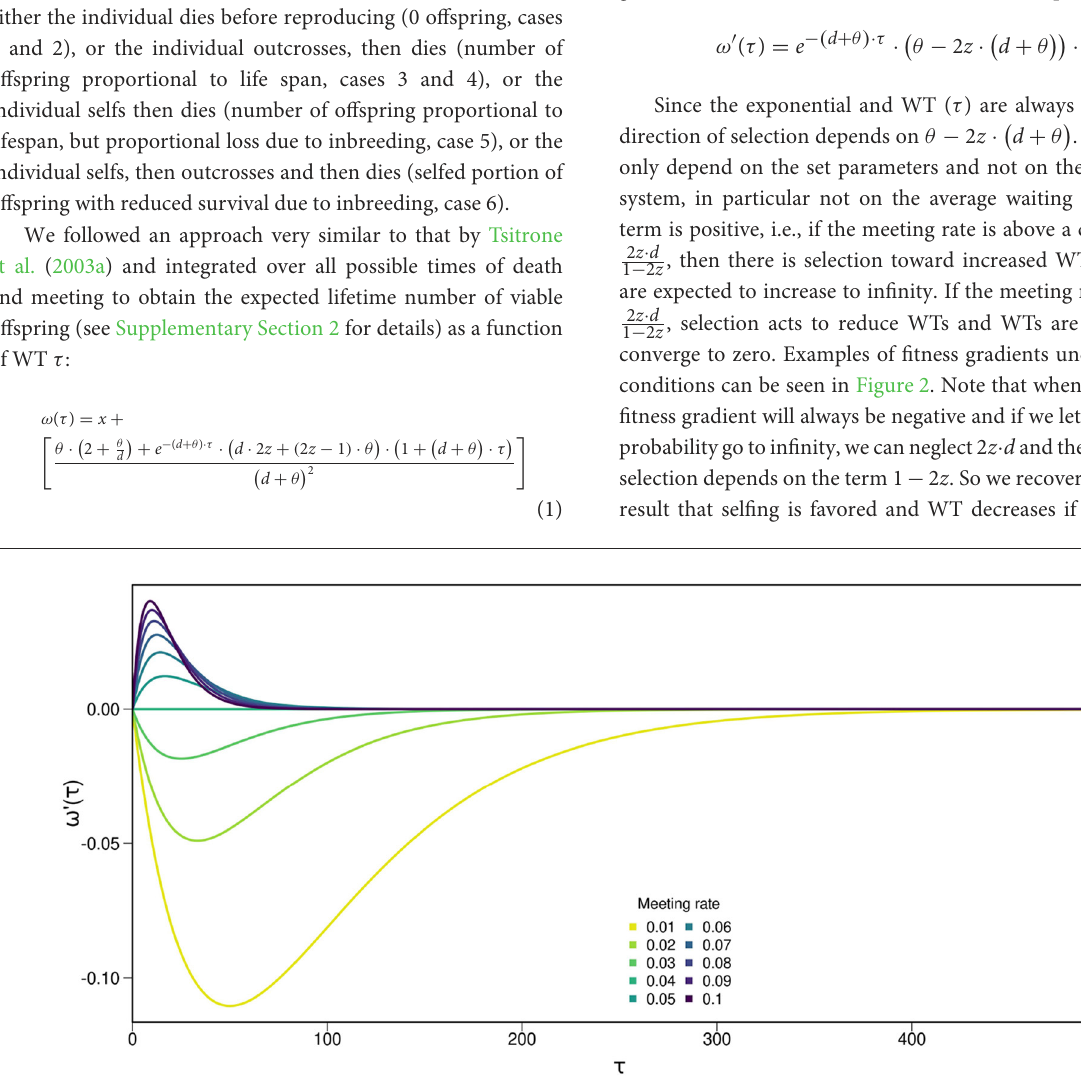
FIGURE2 Results from the mathematical approximation, a simplification of the main individual-based model designed to clarify conditions which may favor long or short WTs. Effects of WT ( τ ) on the fitness derivative ( ω ′ ( τ )), calculated from Equation (2), under different mate encounter rates θ . This mathematical approximation illustrates that fitness ω ( τ ) is highest at either θ = 0 when mate availability is low or τ = ∞ at high mate availability. The critical meeting probability for the parameters we used is θ = 0.04. Assumptions are exponentially distributed time of death and time of first meeting, acquired sperm can be used for the rest of an individual’s life, individuals will never self after having outcrossed, outcrossed sperm is used if present, and ID is constant. In this example, viability of selfed offspring z = 0.4 and probability of death d =